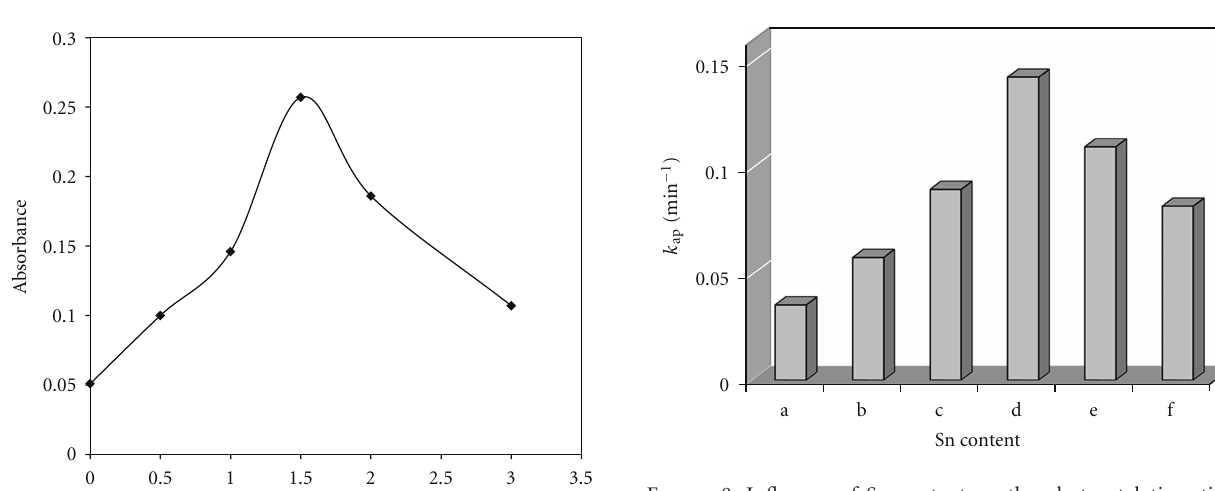
Figure 8: Influence of Sn content on the photocatalytic activity of samples under UV irradiation: (a) 0.0% Sn/TiO 2 , (b) 0.5 mol% Sn/TiO 2 , (c) 1 mol% Sn/TiO 2 , (d) 1.5mol% Sn/TiO 2 , (e) 2 mol% Sn/TiO 2 and (f) 3mol% Sn/TiO 2